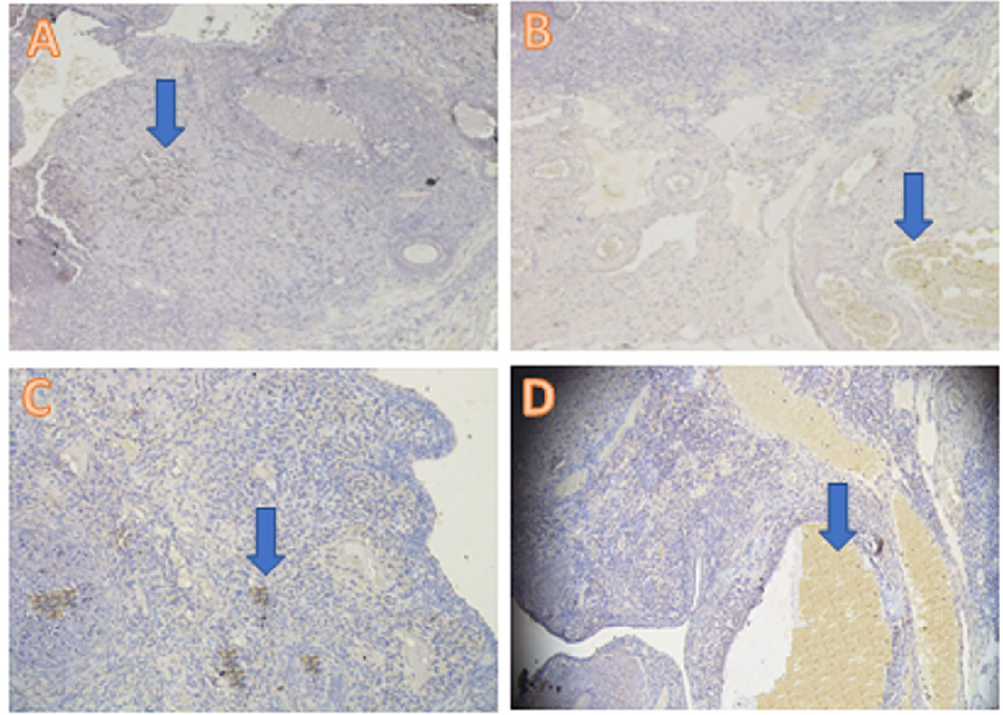
Figure 1. Average score of IL-13 expression (brown): (A) fertile female, negative control group (T (cid:1) ) = 0.30 a (cid:4) 0.48; (B) infertile female, positive control group (T+) = 2.70 b (cid:4) 1.57; (C) infertile female with 30% honey v/v group (T1) = 5.30 c (cid:4) 2.31; (D) infertile female with 50% honey v/v group (T2) = 9.80 d (cid:4) 2.53. (A – D) 400 (cid:3) with the IHC method. IHC = immunohistochemical.